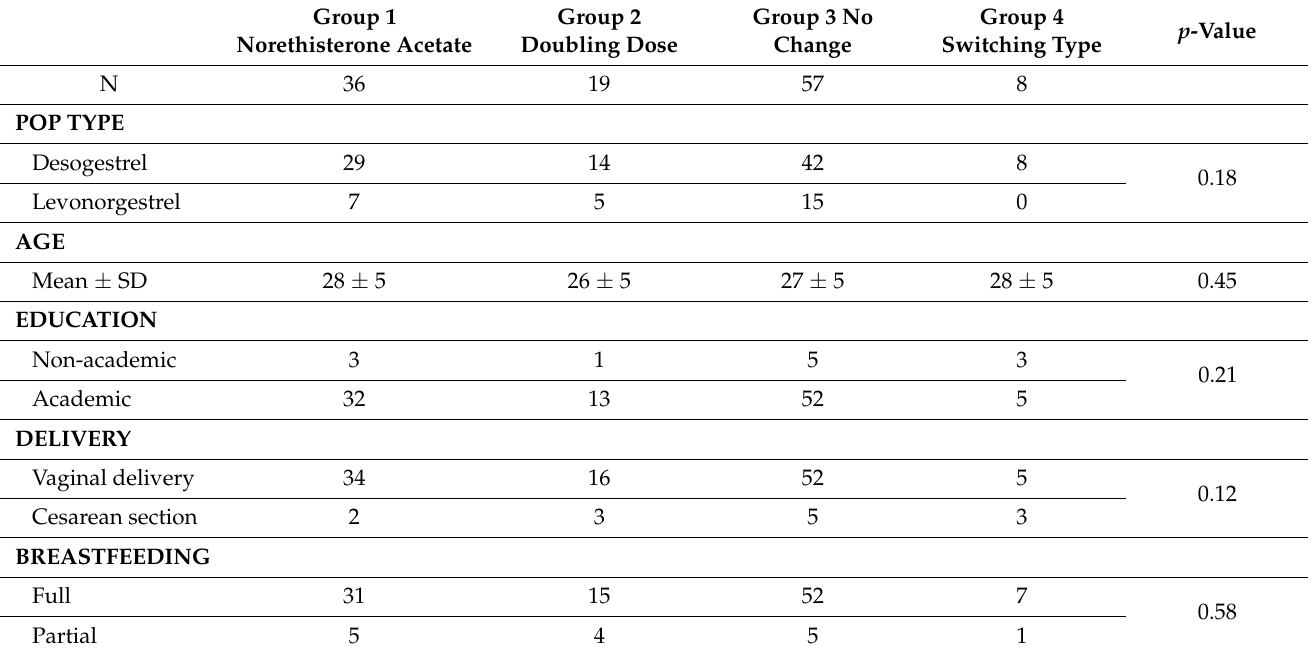
Table 1. Baseline demographic and obstetric characteristics of the study